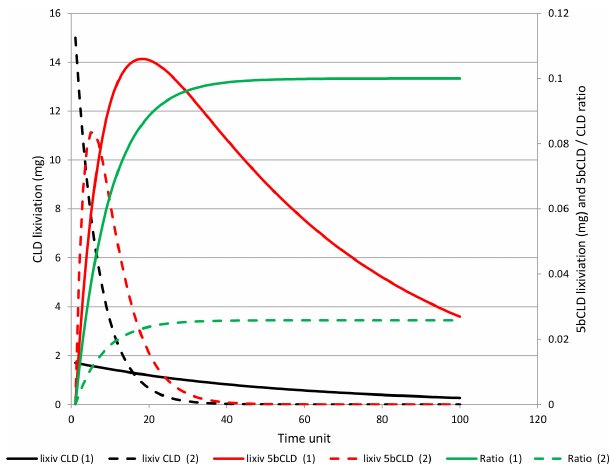
Figure 8. Theoretical evolution of CLD and 5bCLD lixiviation, as well as the 5bCLD / CLD ratio for the two models illustrating (1) conditions for andosols with high soil retention (model And2 in Table 2 – continuous lines) and (2) conditions for nitisols with low soil retention (model Nit1 in Table 2 – dashed